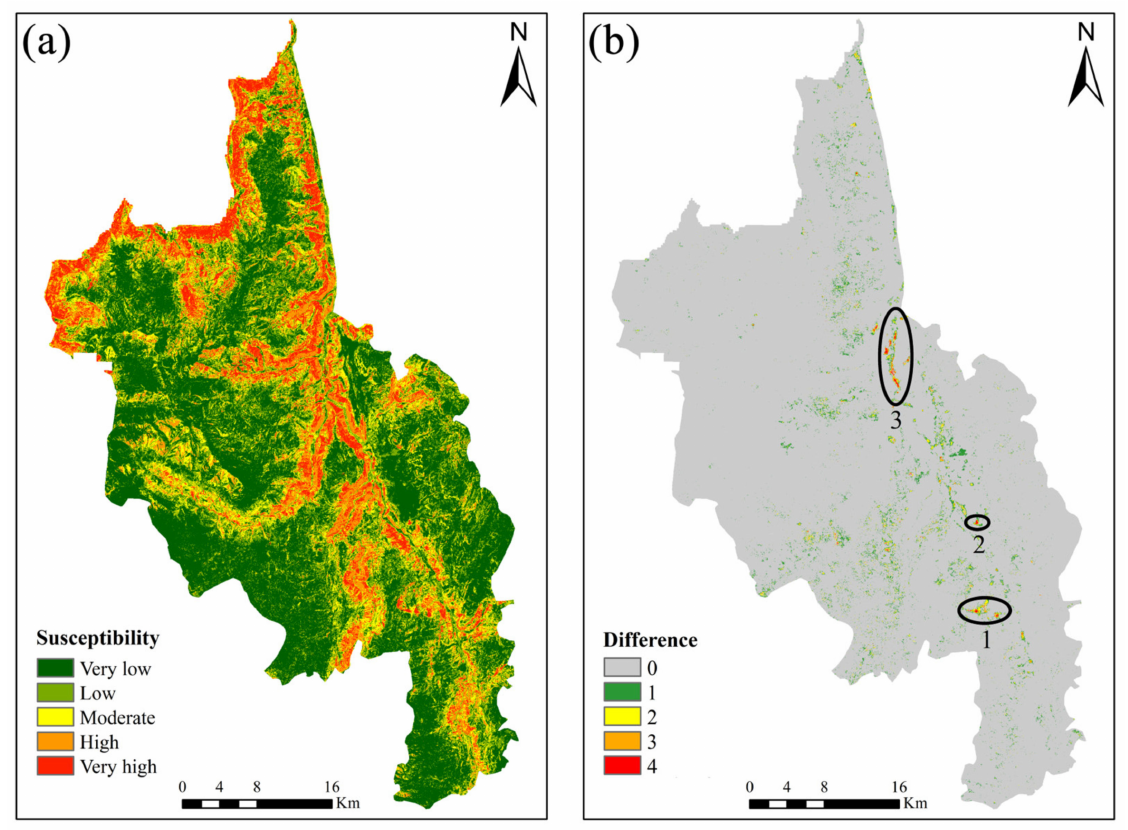
Figure 6. LSM and difference graph after correction. ( a ) shows the LSM after the integrated SBAS- InSAR correction, and ( b ) shows the difference graph before and after the correction. (0, 1, 2, 3, 4 represent the correction class value